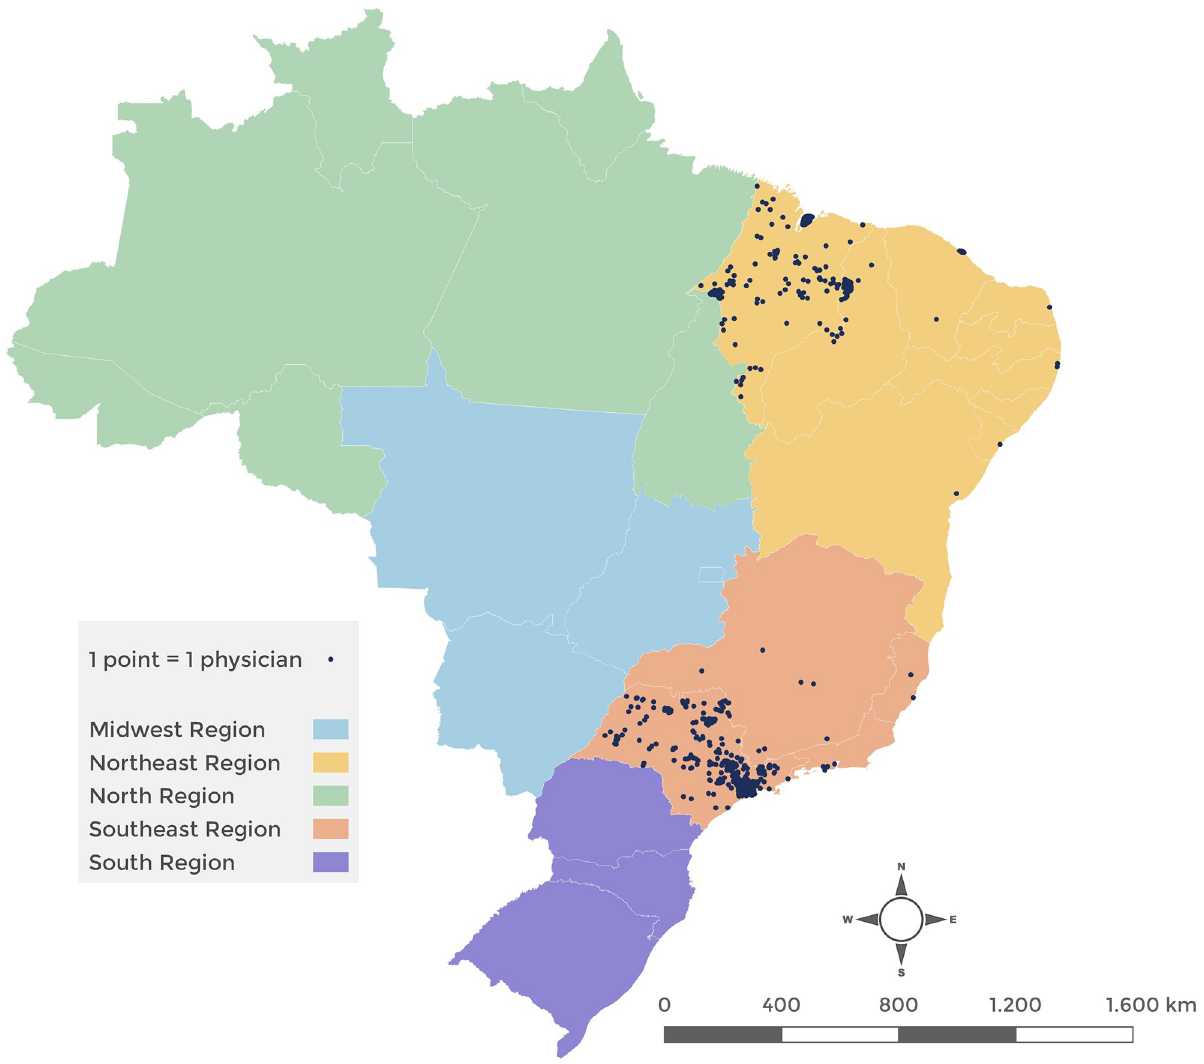
Fig 1. Geographical location of the surveyed physicians in S ã o Paulo and Maranh ã o. Note to Fig 1: Points outside the states of S ã o Paulo and Maranh ã o refer to registered physicians who have recently retired or are active in more than one state. The base layer map of Brazil is from the Brazilian Institute of Geography and Statistics. Link: https://www.ibge.gov.br/geociencias/organizacao-do-territorio/malhas-territoriais/15774-malhas.html?=&t=